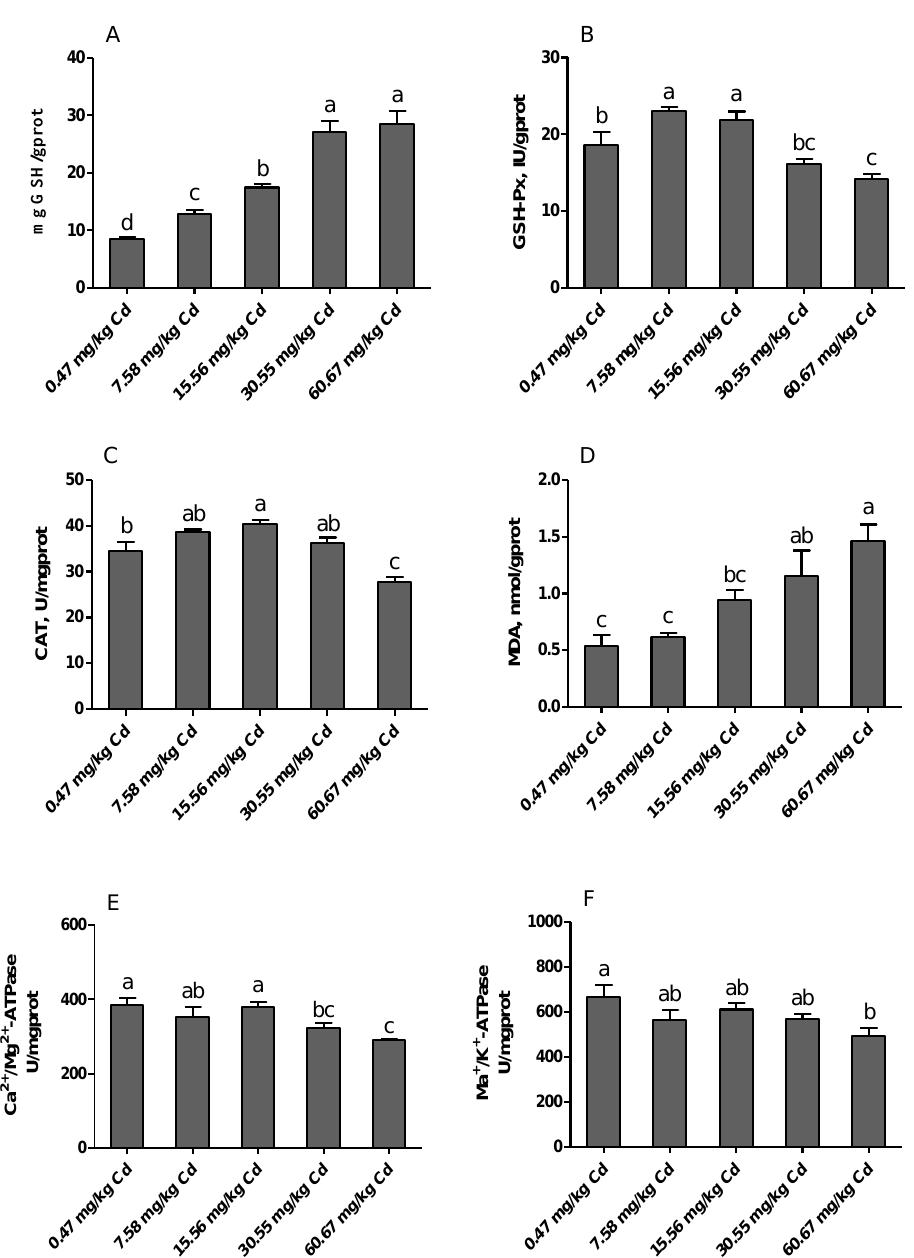
Figure 7. Effects of Cd on the activities of antioxidant enzymes and ATPase in kidney of laying hens. ( A ) GSH, glutathione; ( B ) GSH-Px, glutathione peroxidase; ( C ) CAT, catalase; ( D ) MDA, malondialdehyde; ( E ) Ca 2+ /Mg 2+ -ATPase; ( F ) Na + /K + -ATPase. Values are presented as the mean ± SE ( n = 8). a–d Means with different superscript letters are significantly different ( p < 0.05).